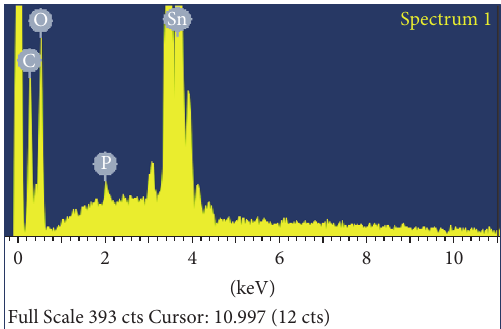
Figure 3: EDX spectrum of SnO 2 @ phenyl-phosphonic acid (S2).